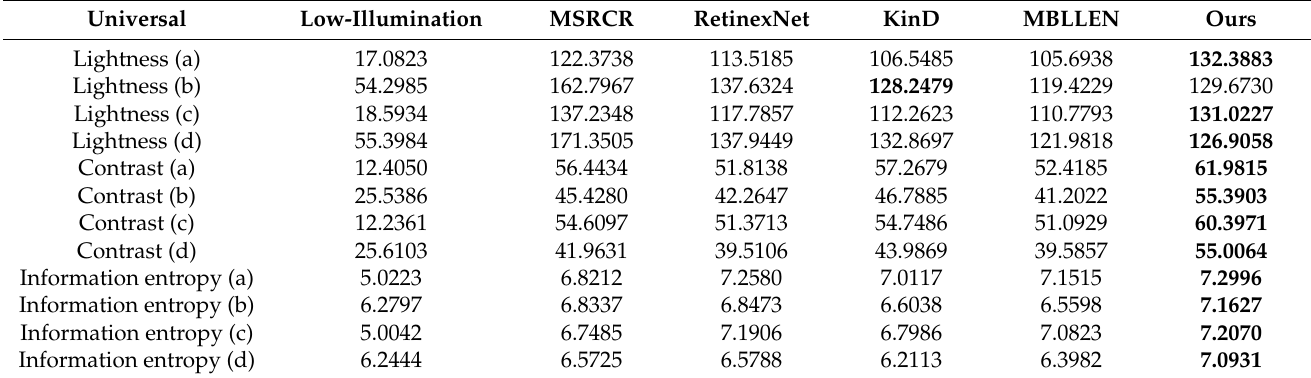
Table 6. Performance comparisons of the algorithms for dedicated pictures under low